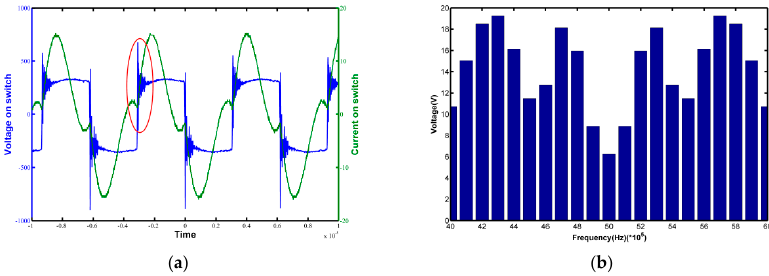
Figure 9. Waveforms of the voltage and current on the switch in a typical hard switch process, and fast fourier transformation (FFT) analysis of the red-encircled waveform of the current on the switch. ( a ) Waveforms of the voltage and current on the switch in a typical hard switch process; ( b ) FFT analysis of the red-encircled waveform in (a).